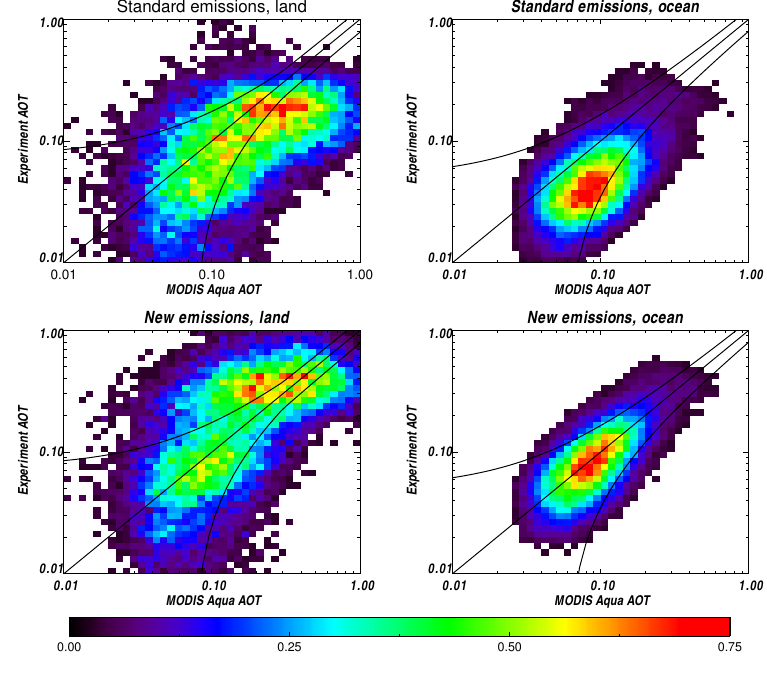
Figure 8. Distribution of co-located experiment and MODIS Aqua AOT over land and ocean for the last three weeks of January 2009. The central black line represents y = x and the outer two black lines represent minimum MODIS AOT errors. The colour bar shows percentage of total